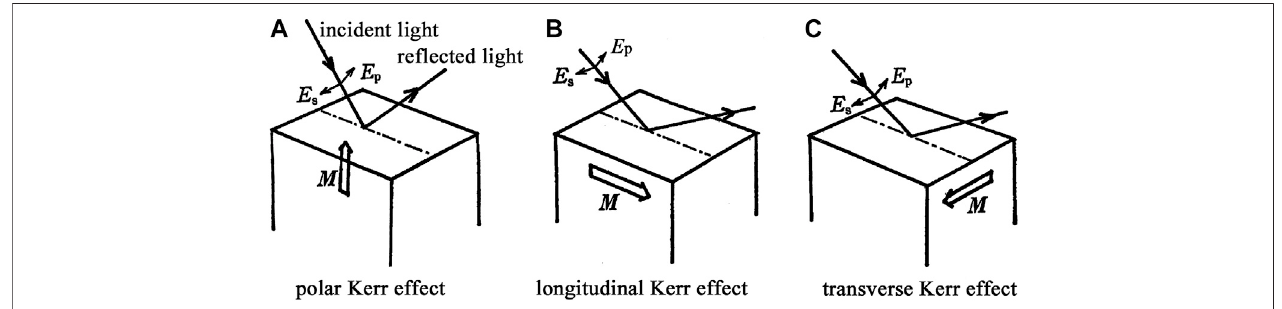
FIGURE 1 | Three types of experimental geometry for MOKE measurement. (A) polar Kerr effect, (B) longitudinal Kerr effect, and (C) transverse Kerr